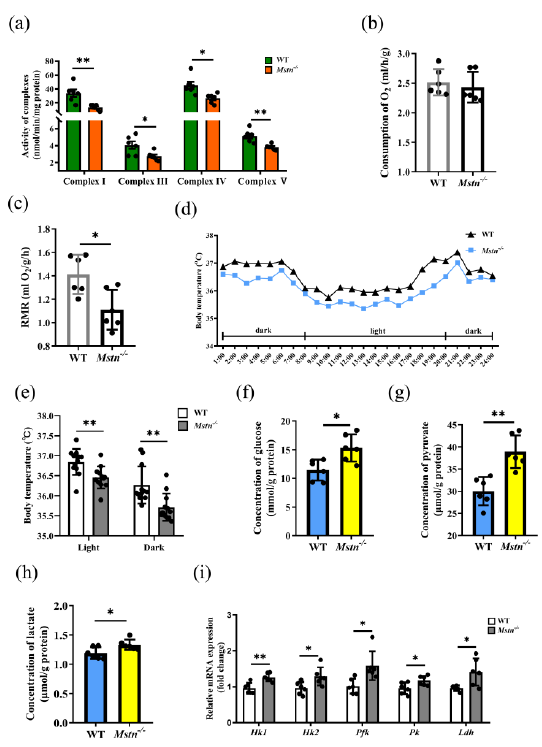
Figure 3. Muscular OXPHOS was inhibited in Mstn −/− mice. ( a ) Mitochondrial complex activity in quadriceps of WT and Mstn −/− mice. ( b ) The total O 2 uptake levels. ( c ) RMR of WT and Mstn −/− mice. ( d ) The body temperature of WT and Mstn −/− mice. ( e ) The light and dark body temperature of WT and Mstn −/− mice. Each dot represents the average temperature of the mice at one time point. ( f ) The glucose concentrations in quadriceps of WT and Mstn −/− mice. ( g ) The pyruvate concentrations in quadriceps of WT and Mstn −/− mice. ( h ) The lactate concentrations in quadriceps of WT and Mstn −/− mice. ( i ) Expression of mRNA for key rate-limiting enzymes involved in glycolysis in quadriceps. All data except ( d ) are presented as mean ± SD. Compared with the control group, * p < 0.05, ** p < 0.01; Student ’ s t-tests were used to calculate the p -values. We used n = 6 mice per group. Except where noted, each dot represents a mouse.